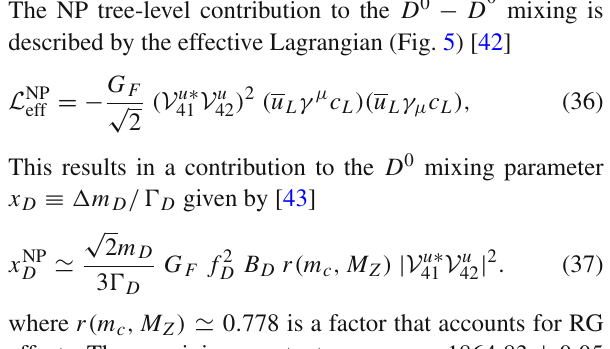
Fig. 4 Analogous plot to that of Fig. 3 but for realistic dominance with θ 14 = 0 . 04 and δ (cid:11) = π/ 2. Various values of s are spanned in steps of 2 × 10 − 4 for s 24 ∈ [ 0 , 1 . 2 × 10 − 3 ] . The curve for s 24 = 0 (in red) is the thicker one in Fig. 3. The region | (cid:3) | NP < (cid:12) is highlighted in K green for m T > 0 . 685